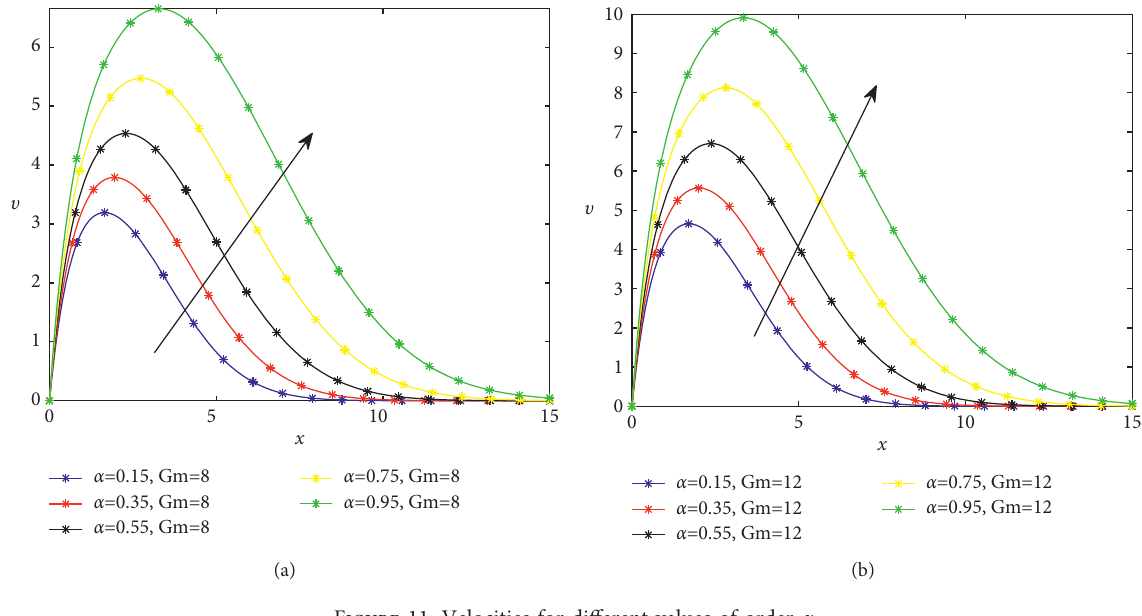
Figure 11: Velocities for different values of order α .